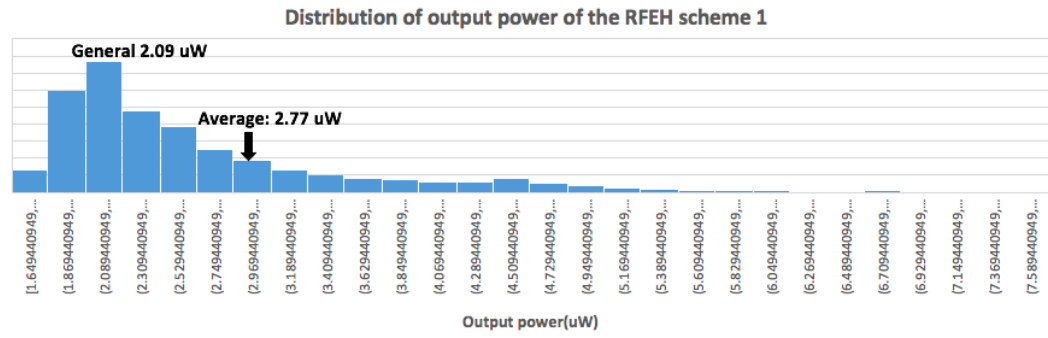
Figure 25. Distribution of output power of scheme 1 at 82 k Ω loads as measured for 1 h.